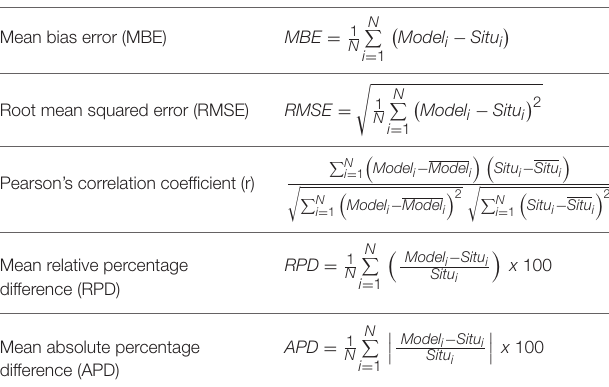
TABLE 5 | Mathematical equations used to compute the statistic parameters.